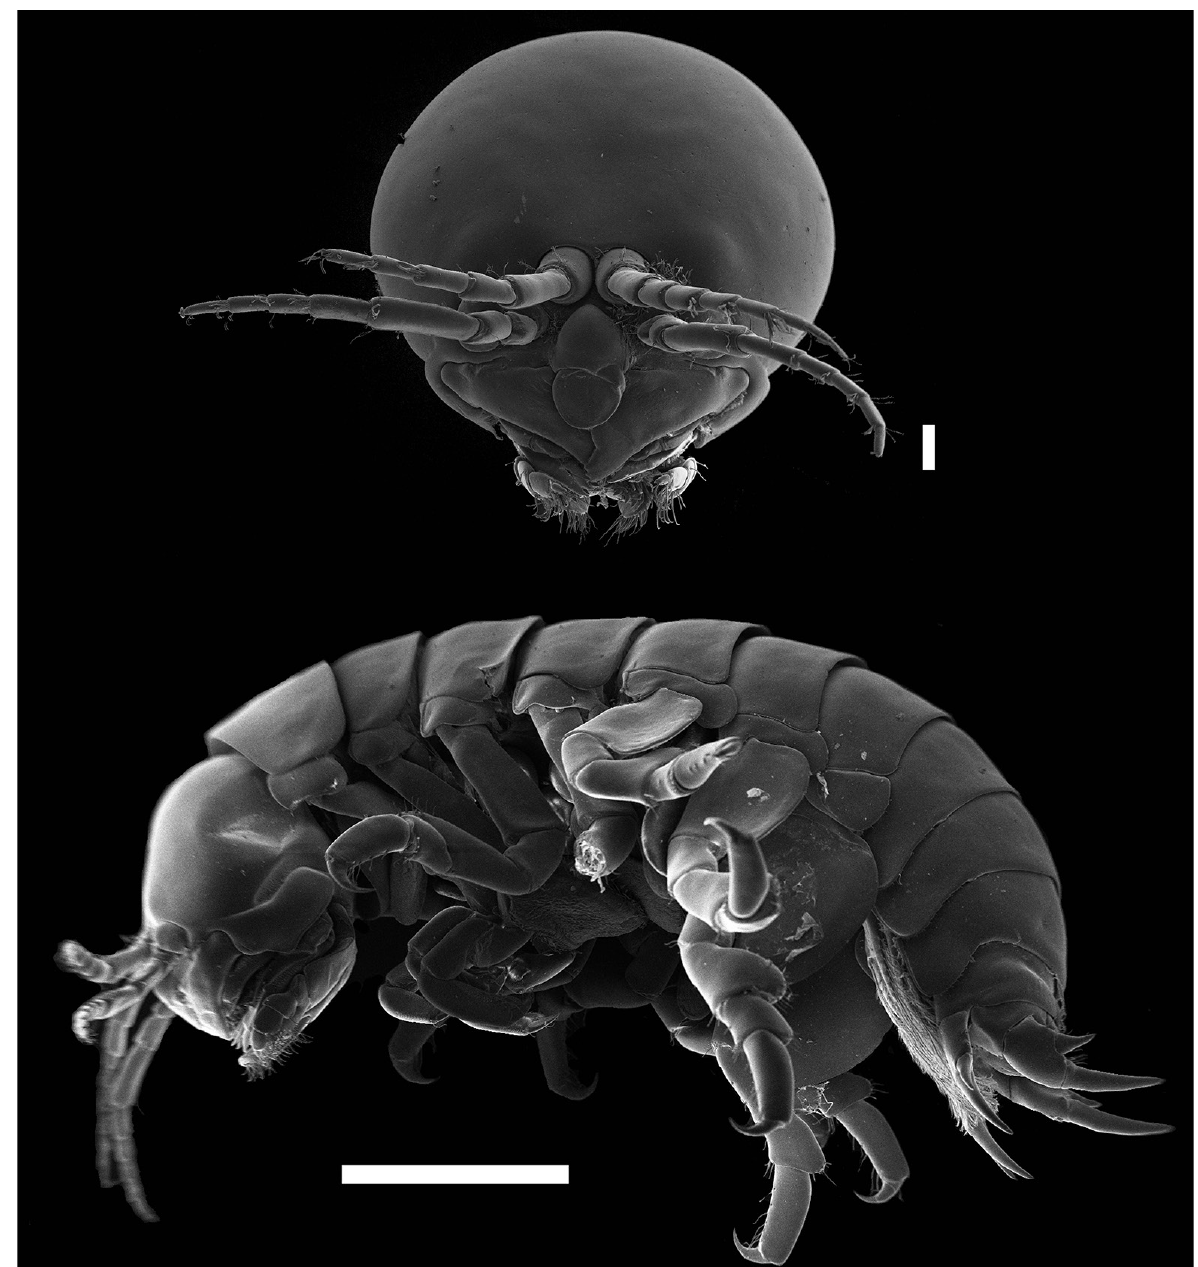
Figure 6. Bircenna thieli sp. nov. paratype SEM, gender indet. 6.3 mm, rego no. ZMH-K 45992, Bicheno, Tasmania, Australia. Scale bars: Head, 100 µm; Habitus, 1